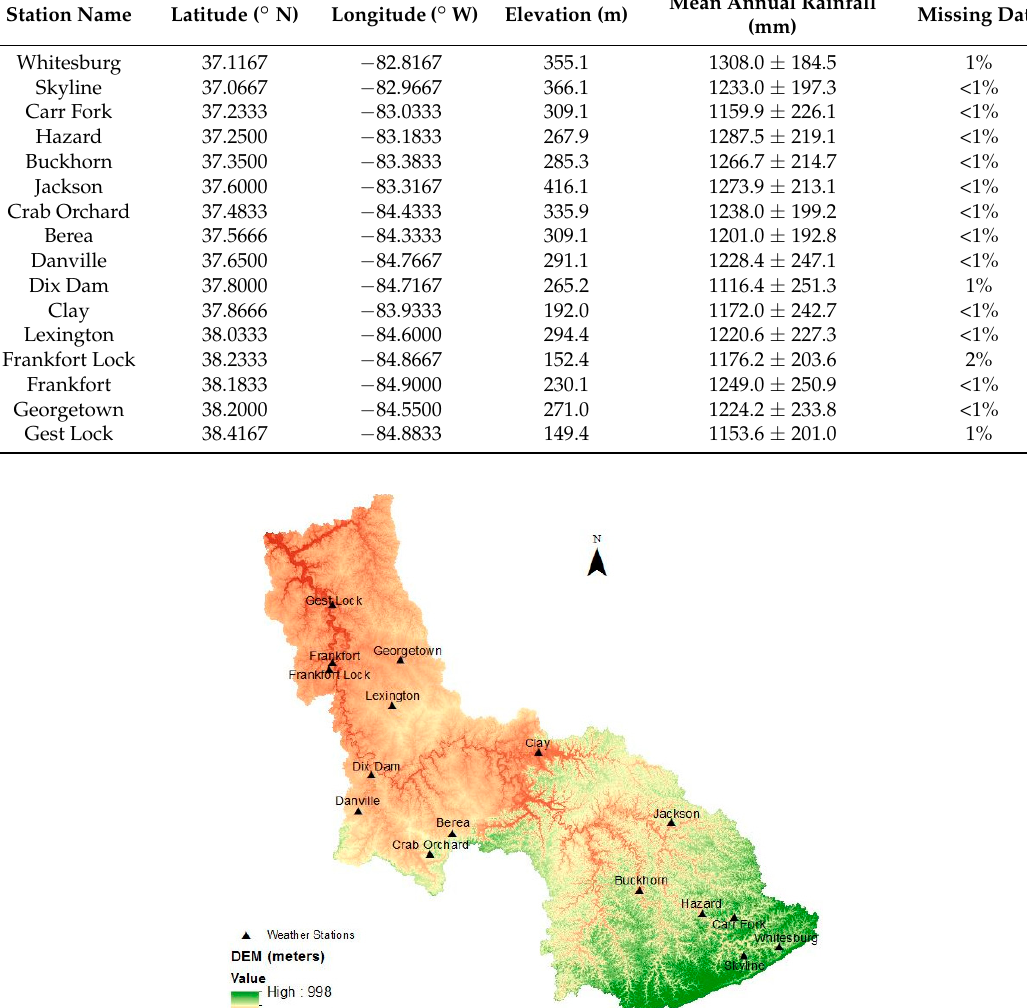
Table 1. Weather stations used in the study.